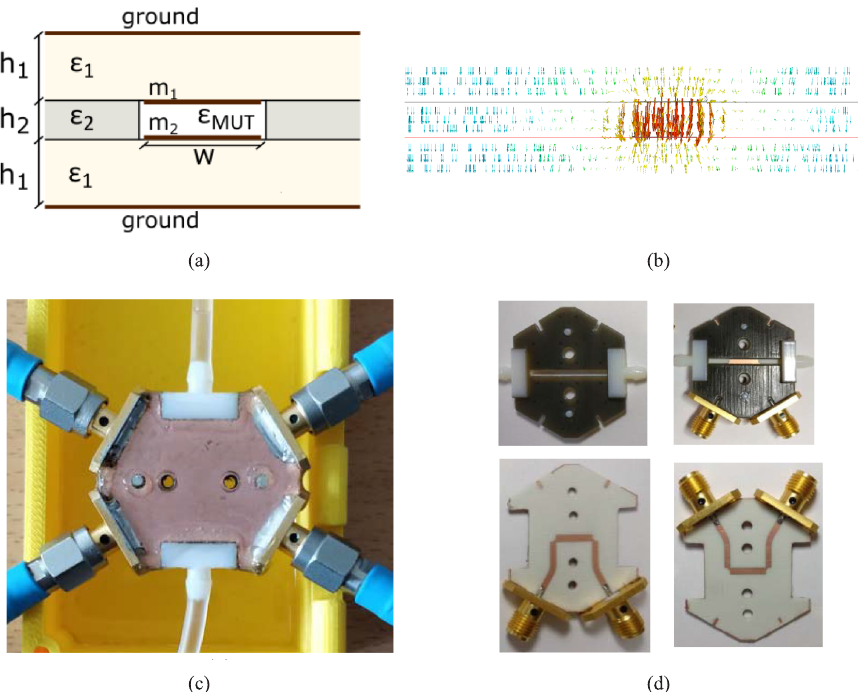
Figure 35. Broadside-coupled line sensor: ( a ) cross-sectional view; ( b ) electric field distribution within the cross section under a differential excitation; ( c ) the microwave microfluidic setup; and ( d ) photographs of the sensor’s components and assembly. Reprinted with permission from Ref.